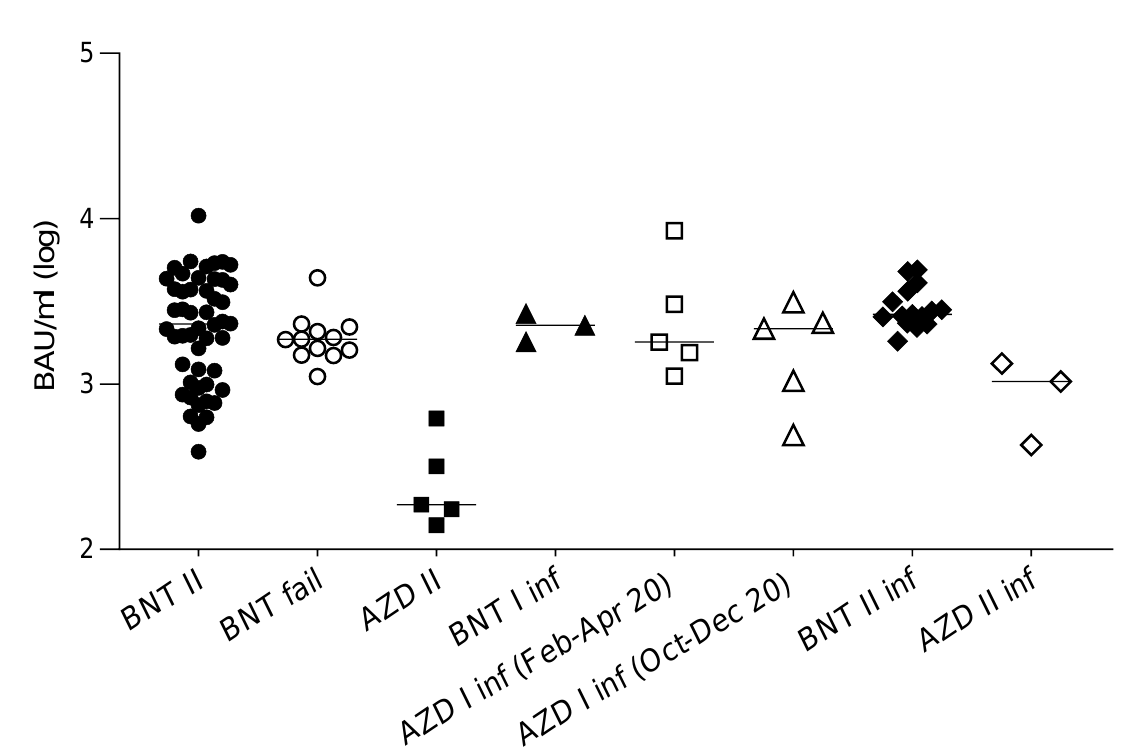
Figure 2. Antibody binding activity of sera from different groups of subjects. Antibody binding activity of: 50 naïve subjects vaccinated with a double dose of the BNT162b2 vaccine (BNT II: black circles); 12 subjects who became infected after a second dose of the BNT162b2 vaccine (BNT fail: white circles); 5 naïve subjects vaccinated with a double dose of AZD1222 (AZD II: black squares); 3 subjects vaccinated with a single dose of the BNT162b2 after natural infection (BNT I inf; black triangles); subjects vaccinated with a single dose of the AZD1222 vaccine after natural infection contracted between February and April 2020 (AZD I inf (Feb-Apr 20): white squares, n = 5), and between October to December 2020 (AZD I inf (Oct-Dec 20): white triangles, n = 5); subjects vaccinated with a double dose of the BNT162b2 vaccine after natural infection (BNT II inf: black diamonds n = 15), and the AZD1222 vaccine after natural infection (AZD II inf: white diamonds, n = 3). Values are expressed in binding antibody units (BAU/mL) according to the WHO standard. Horizontal lines represent medians.